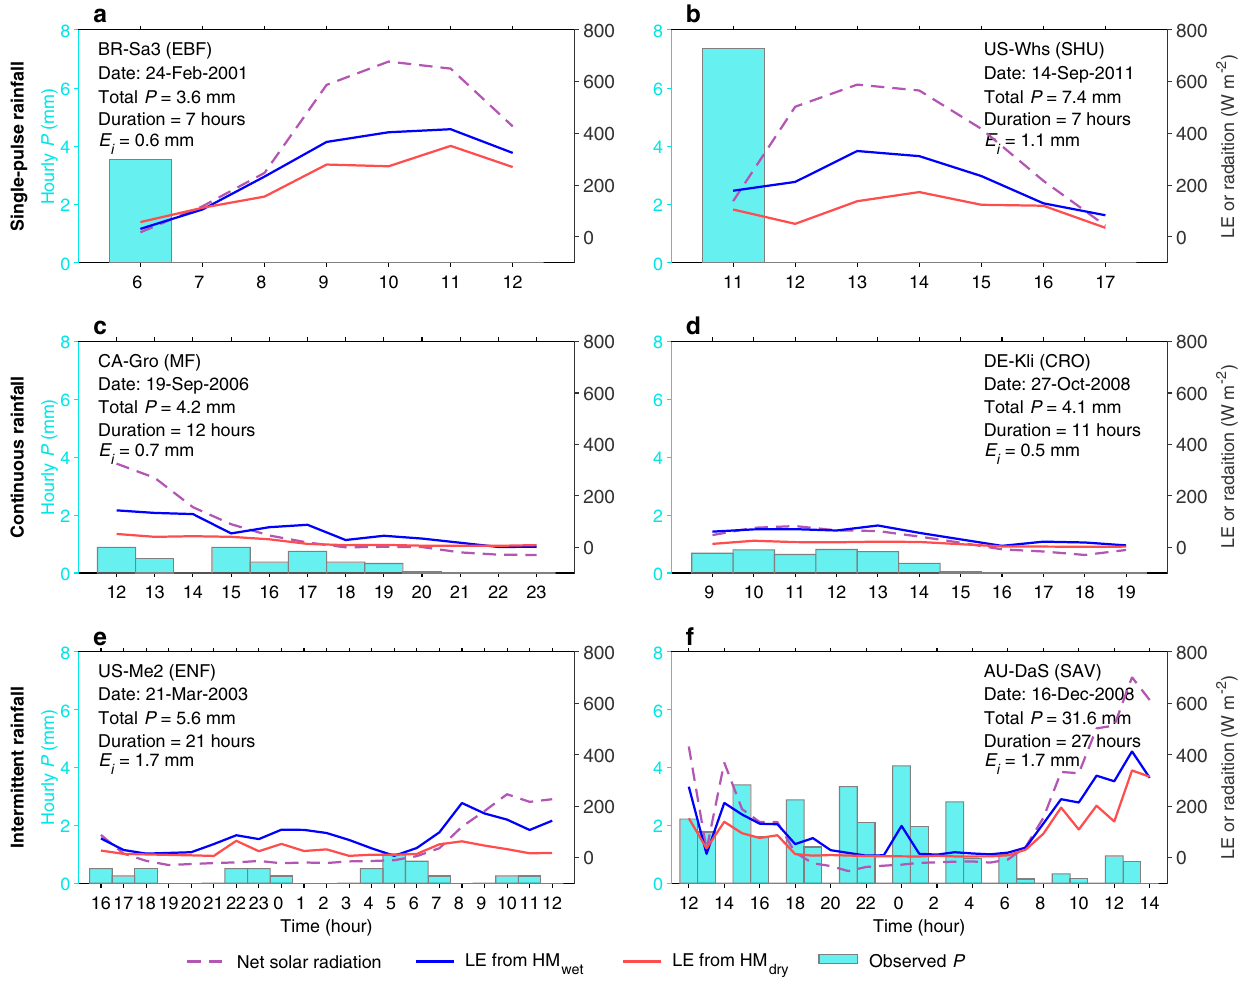
Fig. 2| Casesofrainfallinterceptionprediction indifferent rain events. Hourly time series of latent heat fl ux (LE) for several cases of rain events, as estimated by hybrid models trained with wet samples (HM wet , blue curves) and dry samples (HM dry ,redcurves).Thesecasesaregroupedintothreegeneraltypes:single-pulse rainfall ( a , b ), continuous rainfall ( c , d ) and intermittent rainfall ( e , f ). Cyan bars